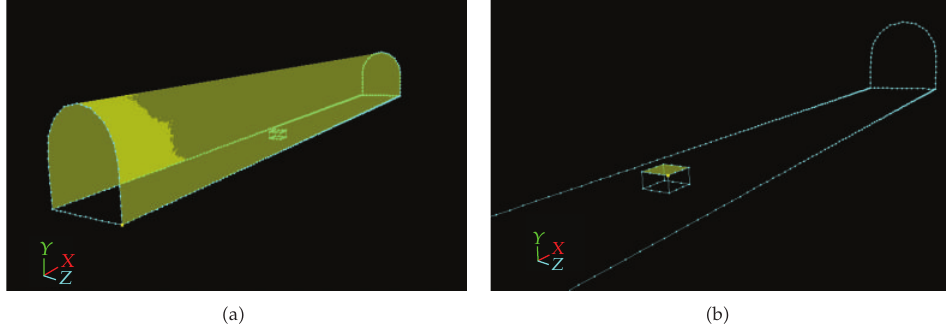
Figure 1: Model 1 and Model 2. The tunnel roof and side walls are highlighted in (cid:2) a (cid:3) ; the hydrogen inlet is highlighted in (cid:2) b (cid:3) .